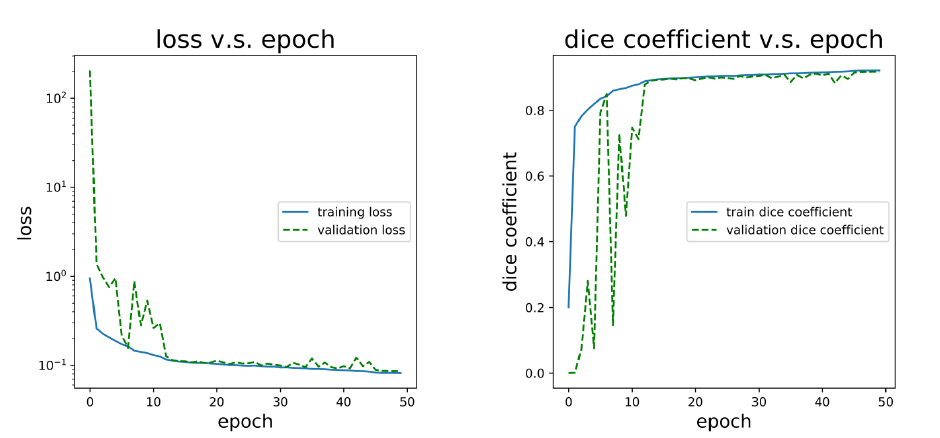
Fig.6. Loss and dice coefficient v.s. epoch